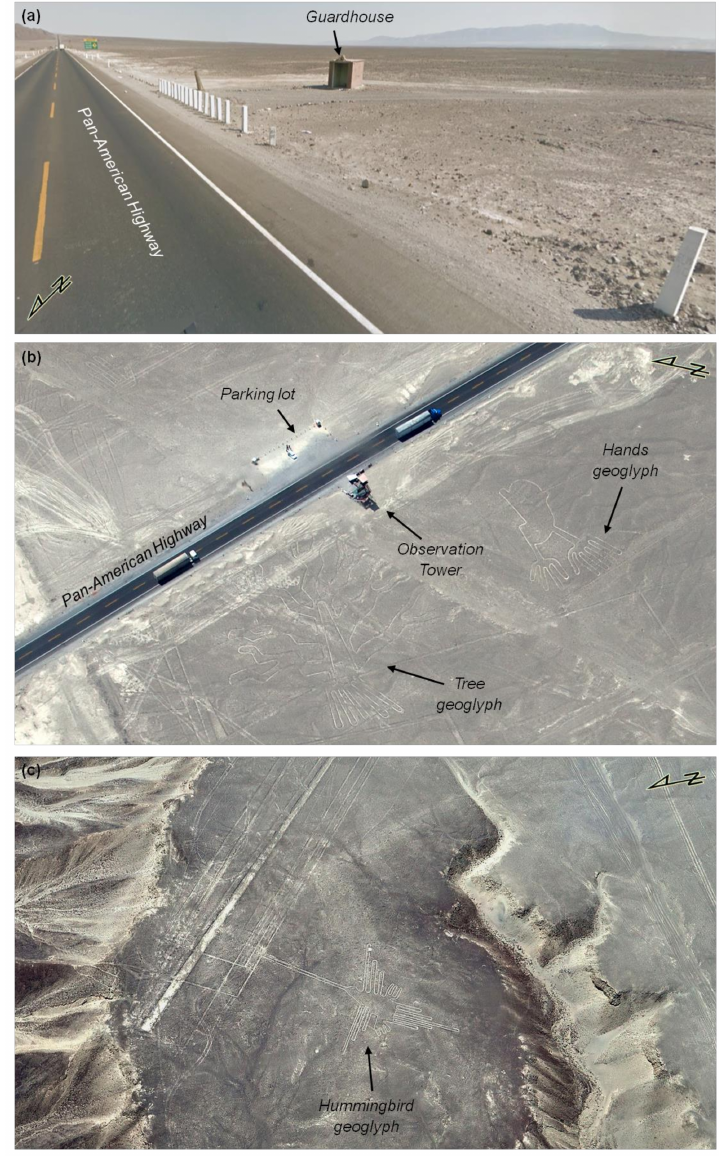
Figure 2. Overview of the locations investigated in this paper: ( a ) 2015 photograph of the section of the Pan-American Highway where the “plowing” event occurred on 27 January 2018 (source: Street View © 2018 Google); and 2013 aerial views acquired over: ( b ) the Observation Tower and its parking lot, with indication of the Hands and Tree geoglyphs; and ( c ) the plateau where the Hummingbird geoglyph is located and the surface disturbance event occurred on 8 December 2014 (photo credits: Unukorno; source: Wikimedia